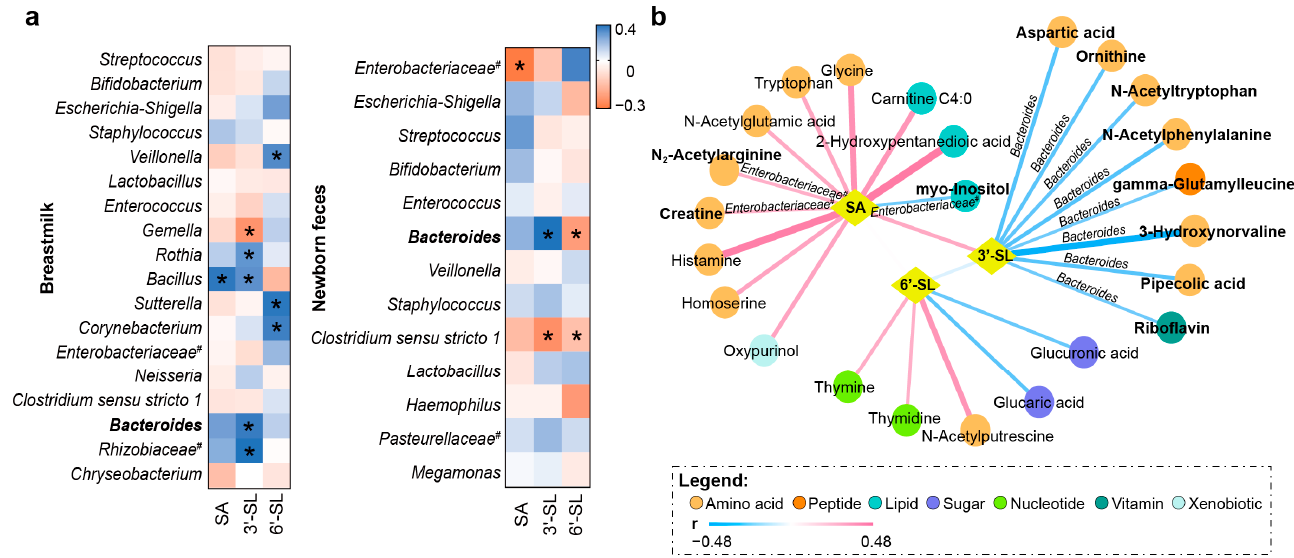
Figure 3. Interaction between breastmilk sialylated oligosaccharides and the newborn gut microbi- ota as well as fecal metabolome. ( a ) Heatmap of the associations between breastmilk sialylated oligosaccharides and breastmilk microbiota or newborn gut microbiota. Asterisks (*) in heatmap mean significant correlation (|R 1 | > 0.2 and p < 0.05). Pound sign (#) indicates the unclassified bacteria at the genus level. ( b ) Partial correlation analysis of breastmilk sialylated oligosaccharides and the newborn fecal metabolites. Correlations with |R 1 | > 0.2 and p < 0.05 are included in the network. Fecal metabolites marked in bold indicate the gut bacteria-mediated correlations between breastmilk SA/3 ′ -SL/6 ′ -SL and infant fecal metabolites.